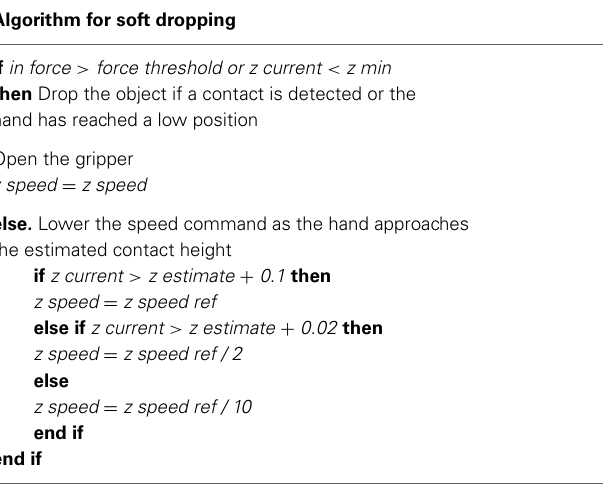
Table 1 | z estim, is the estimated height from the